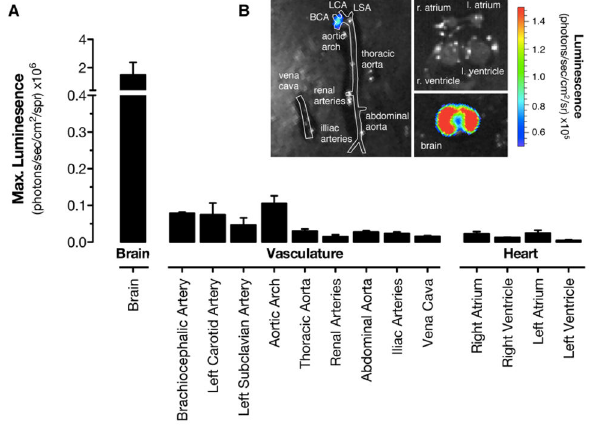
Figure 3. Distribution of luciferin-dependent bioluminescence in cardiovascular tissue from Cox2 fLuc/+ mice. (a) Quantification of basal expression from the aortic tree, vena cava, chambers of the heart and, for comparison, brain from Cox2 fLuc/+ mice and (b) and representative images of bioluminescence. Arteries, veins and chambers of the heart were essentially devoid of expression from the Cox2 gene, in comparison with the brain as a reference tissue. The only exception to this was weak, but detectable, expression in the region of the aortic arch.